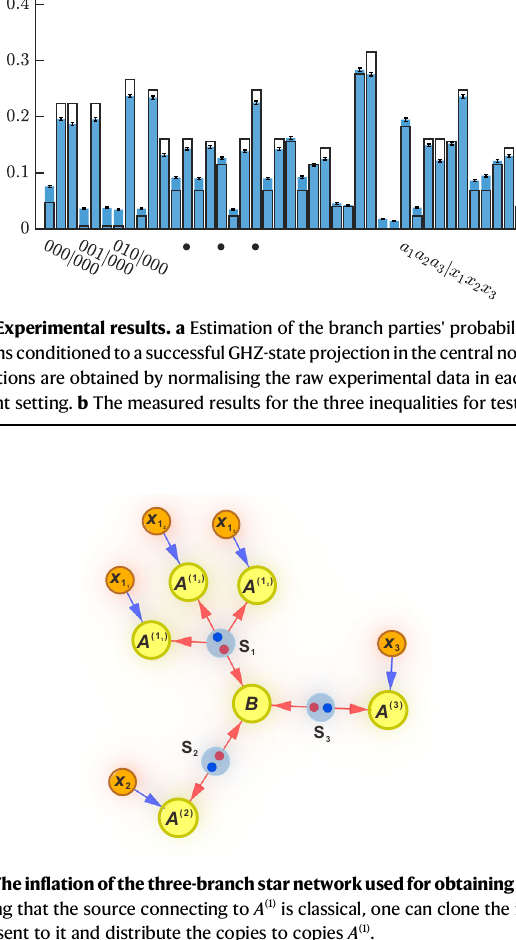
Fig.4|Thein fl ationofthethree-branchstarnetworkusedforobtainingEq.(4). Assuming that the source connecting to A (1) is classical, one can clone the infor- mation sent to it and distribute the copies to copies A (1)